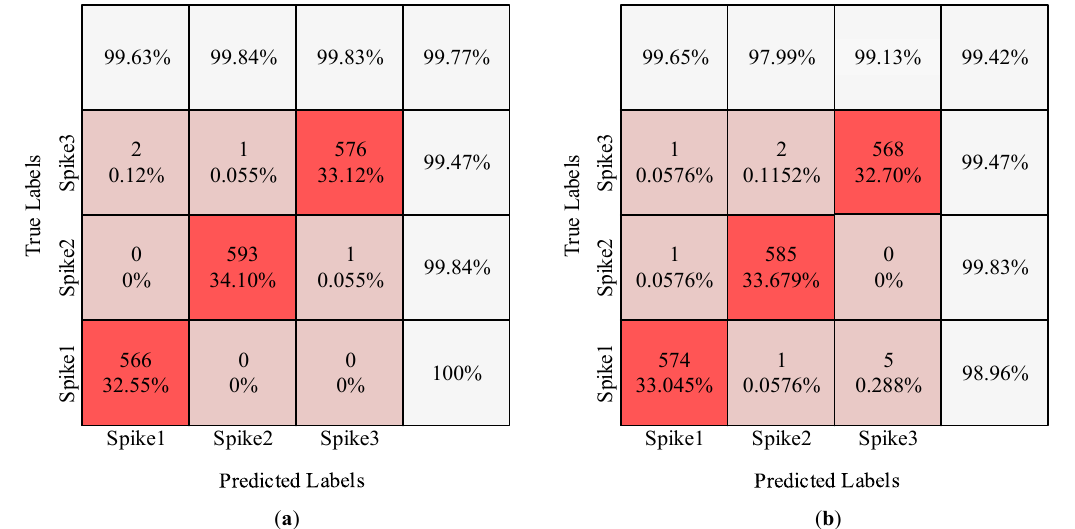
Figure 5. Confusion matrix: ( a ) C_Easy1_noise015; ( b ) C_Difficult1_noise015.